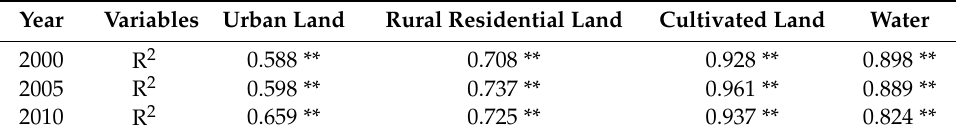
Table 6. The relationships between each land use type and the distribution of grassland fires by regression analysis (land use in 2000, land use in 2005, land use in